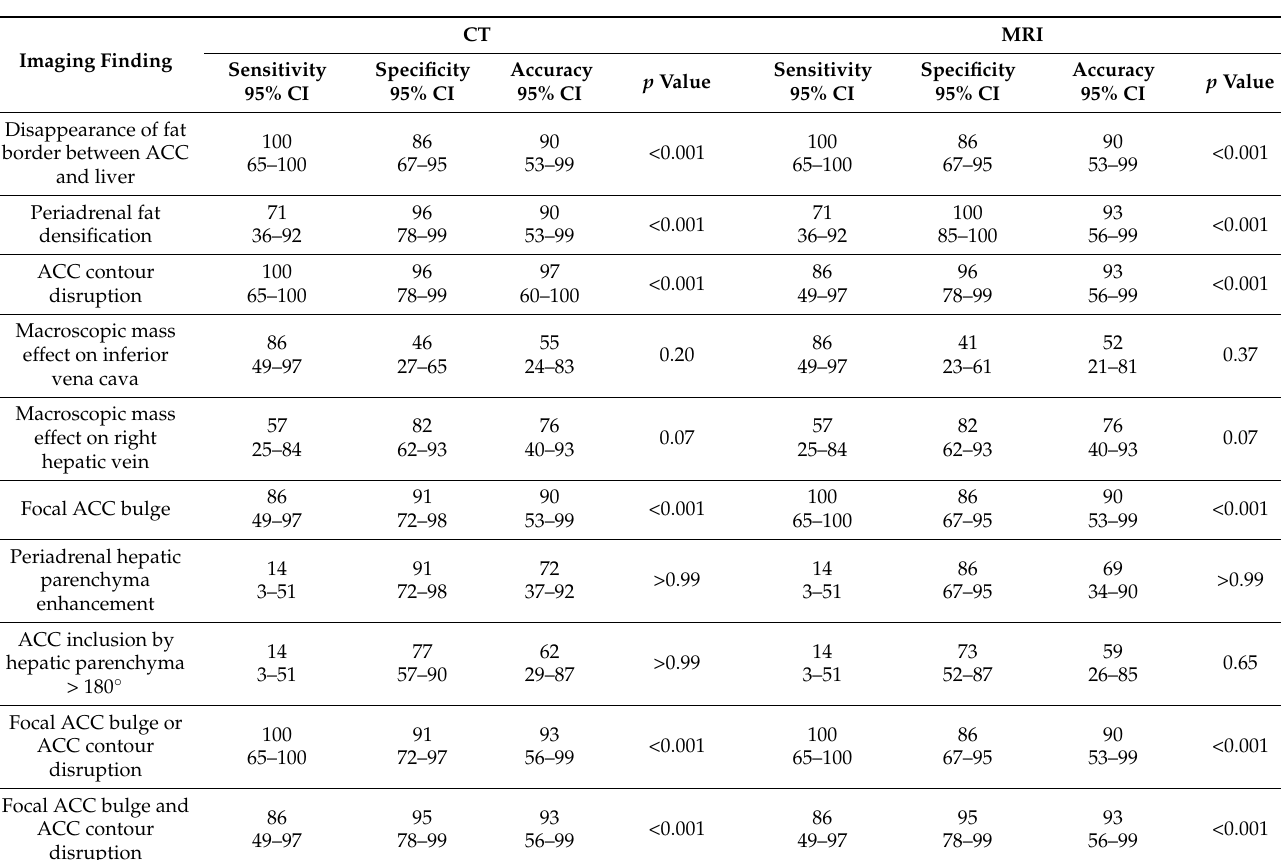
Table 7. Sensitivity, specificity, and accuracy of categorical CT and MRI variables for the prediction of direct liver involve- ment in 29 patients with operated right-sided adrenocortical